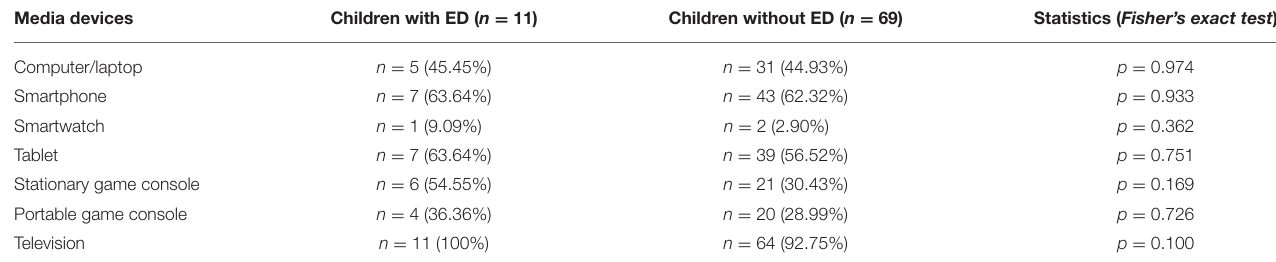
TABLE 4 | Access to different media devices in children with ED and children without